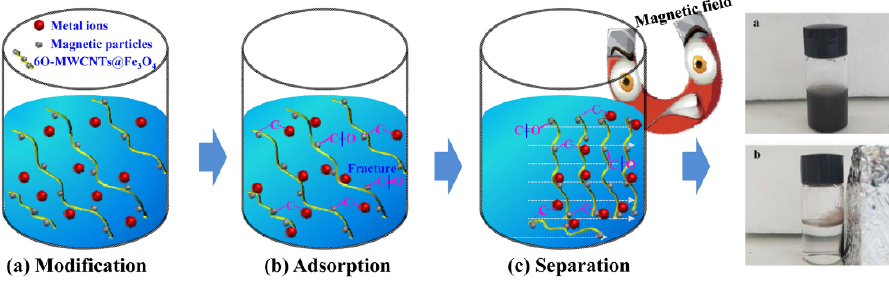
Figure 2. The mechanism of heavy metal ion absorption by 6O-MWCNTs@Fe 3 O 4 in wastewater [91].